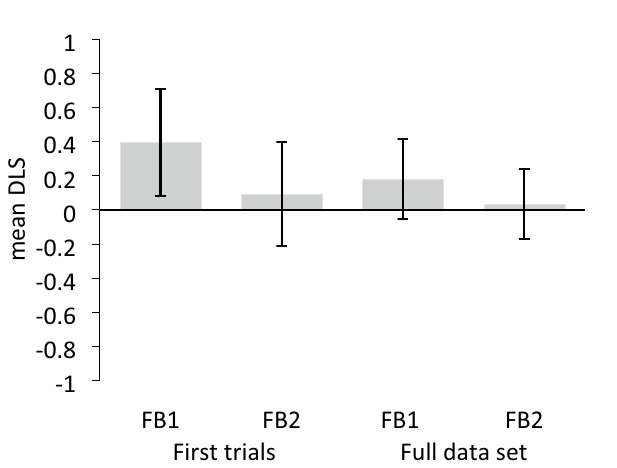
Figure 2. Proportion of correct first saccades ( a ) and correct first looks ( b ) in each condition (FB1, FB2) for the first trial and the full set analyses. Numbers written on the bars represent total numbers of observation.